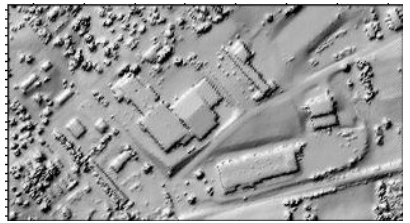
Figure 8: Houses extracted by using single LiDAR data (Courtesy of Ren et al. (2009))